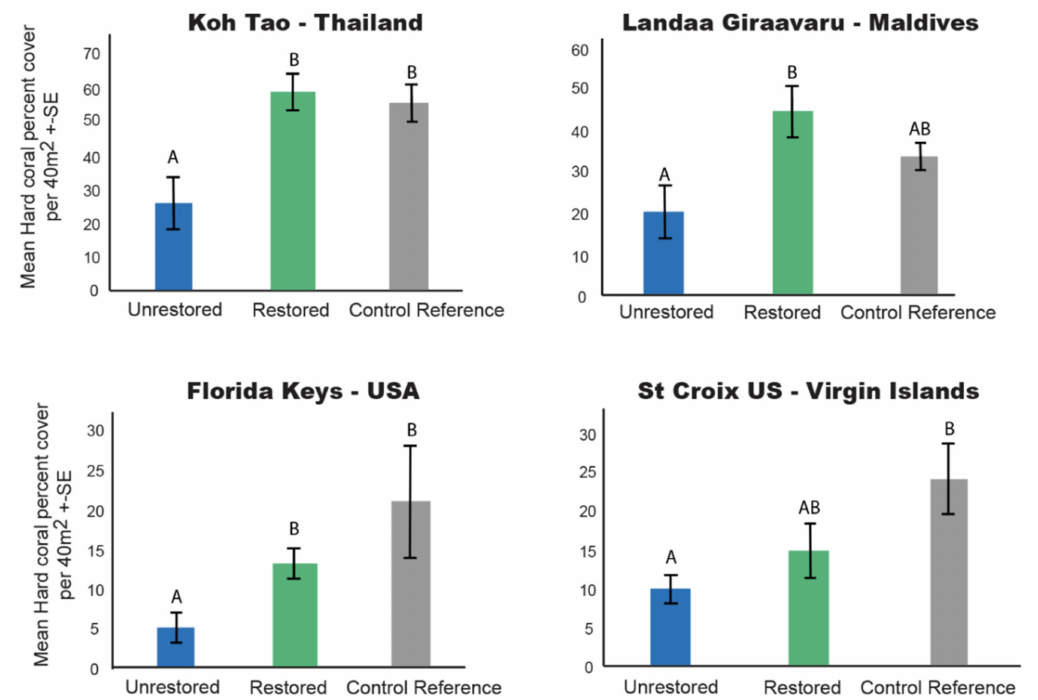
Figure 3. Mean percent cover of hard corals per 40-m 2 belt transect ( ± SE) compared among treatments (unrestored, restored, control reference sites) at each of the four locations. Letters above each histogram indicate whether mean values di ff er significantly (di ff erent letters) or are statistically indistinguishable (same letters). n = 9 transects per treatment in Koh Tao, Landaa Giraavaru, and the Florida Keys; In St Croix, n = 8 transects for unrestored and restored treatments, n = 6 transects for the control reference